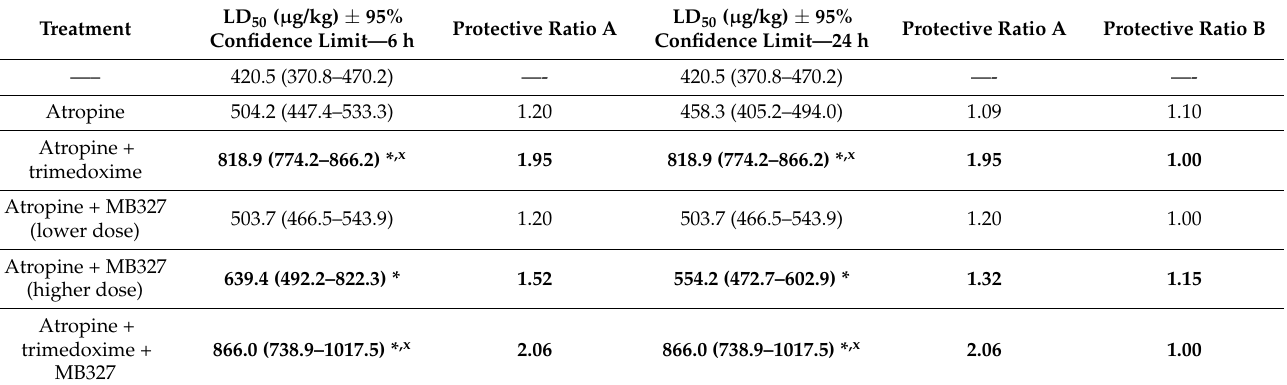
Table 3. The effect of experimental endpoint on the protection provided against the lethal effects of tabun in